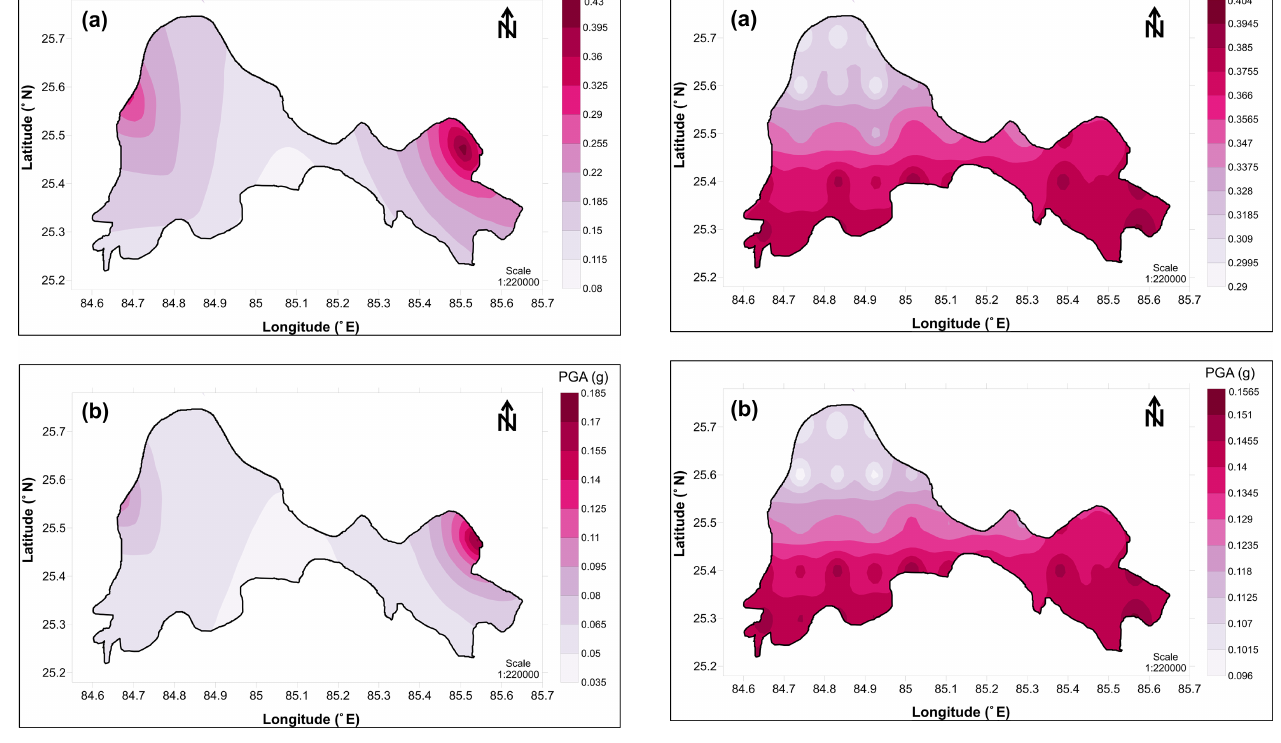
Figure 8. (a) PSHA map for Patna urban centre for 2% probability of exceedance in 50 years using the classical approach. (b) PSHA map for Patna urban centre for 10% probability of exceedance in 50 years using the classical approach.